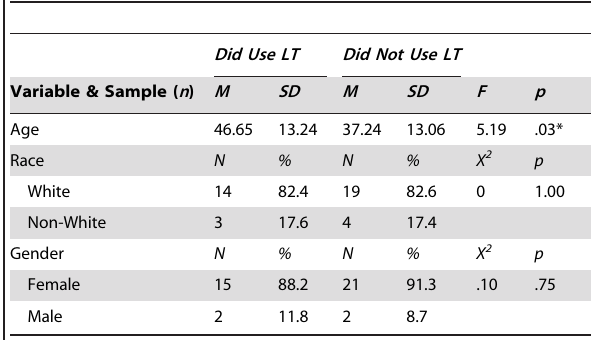
Table 1. Demographic variables compared between those that did and did not use